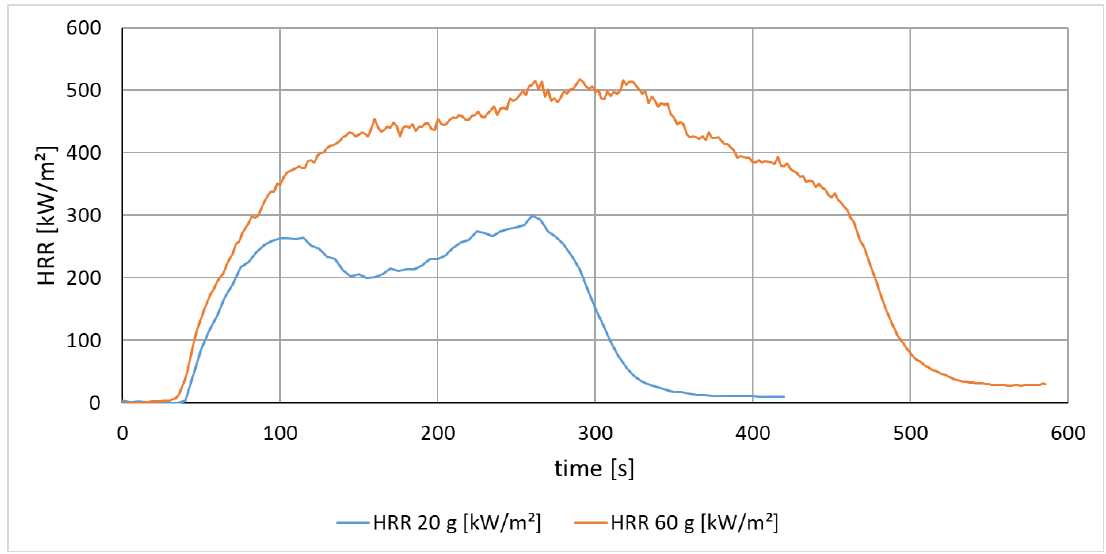
Figure 7. Comparison of the HRR of PA 6 with 20 g and 60 g (radiation intensity 50 kW/m 2 ).